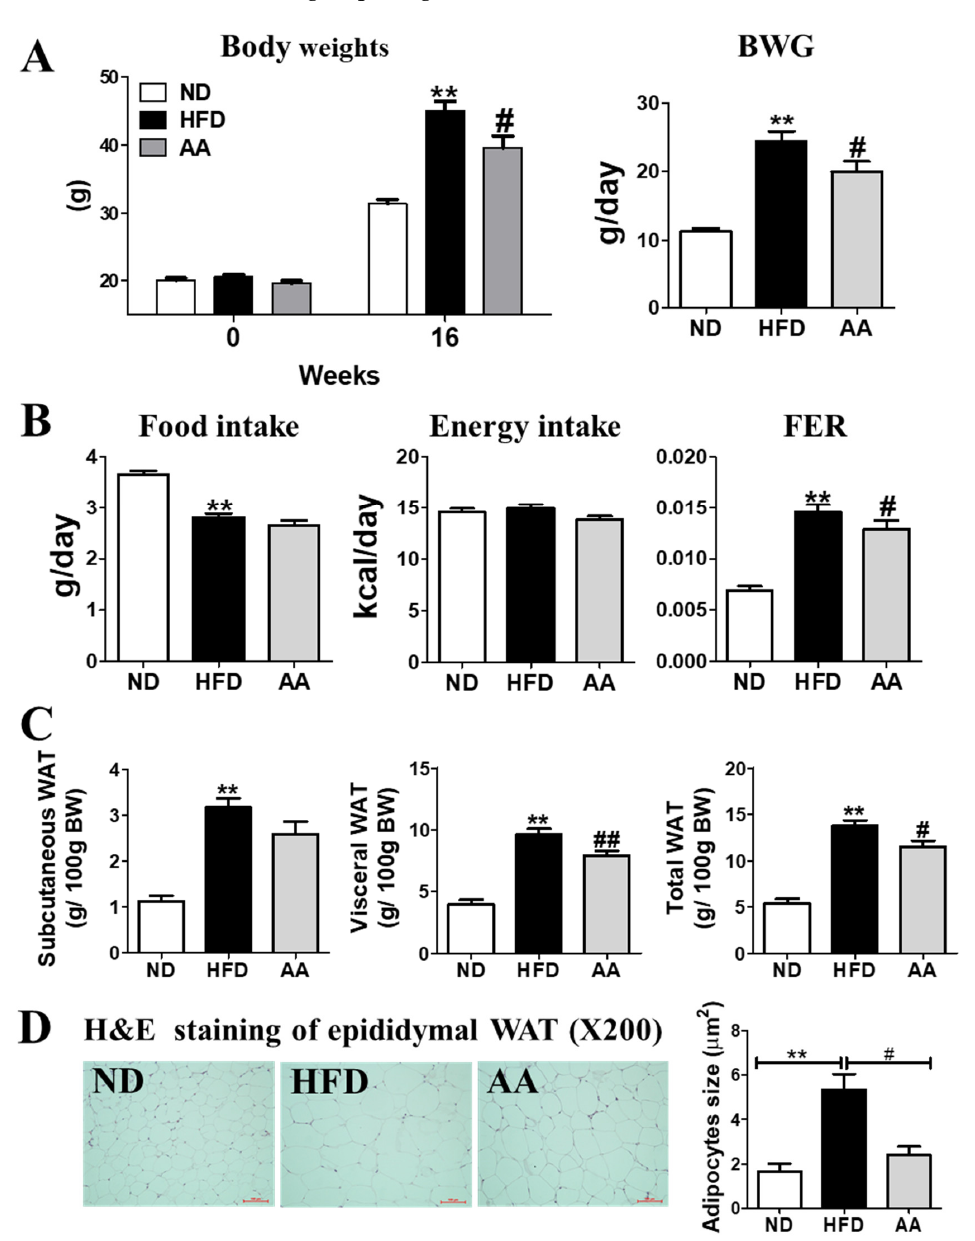
Figure 1. Effect of Artemisiae argyi water extract supplementation on diet-induced obesity. ( A ) Body weight and body weight gain; ( B ) food intake, energy intake, and FER; ( C ) adipose tissue weight; and ( D ) adipocyte morphology of the study groups. Data are presented as the mean ± standard error of the mean. Significant differences between HFD and ND are indicated as ** p < 0.01. Significant differences between the HFD and AA groups are indicated as # p < 0.05, ## p < 0.01. ND, normal diet (AIN-93G, n = 10); HFD, high-fat diet (60% kcal from fat, n = 10); AA, HFD + A. argyi water extract (1.5%, w/w , n = 10); BWG, body weight gain; FER, food efficiency ratio: body weight gain/energy intake per day; WAT, white adipose tissue.